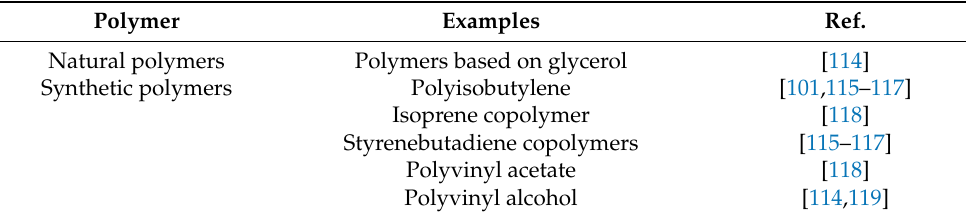
Table 3. Polymers used in chewing gums’ formulations.